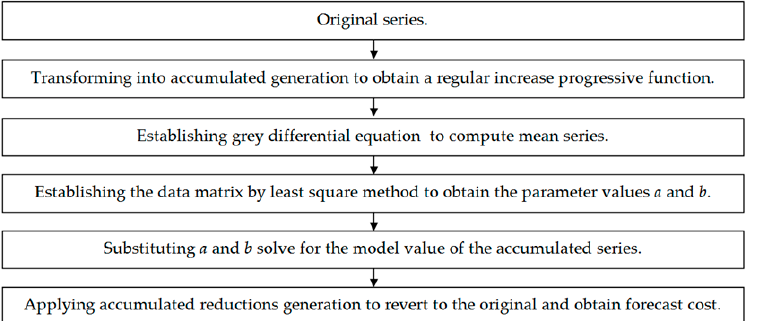
Figure 6. The process of grey prediction (Data from: http://citeseerx.ist.psu.edu/ [23,24],